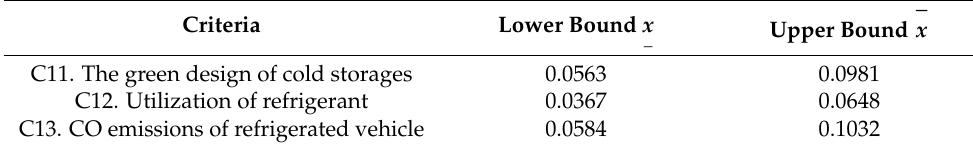
Table 9. The grey weights of environmental (C1).